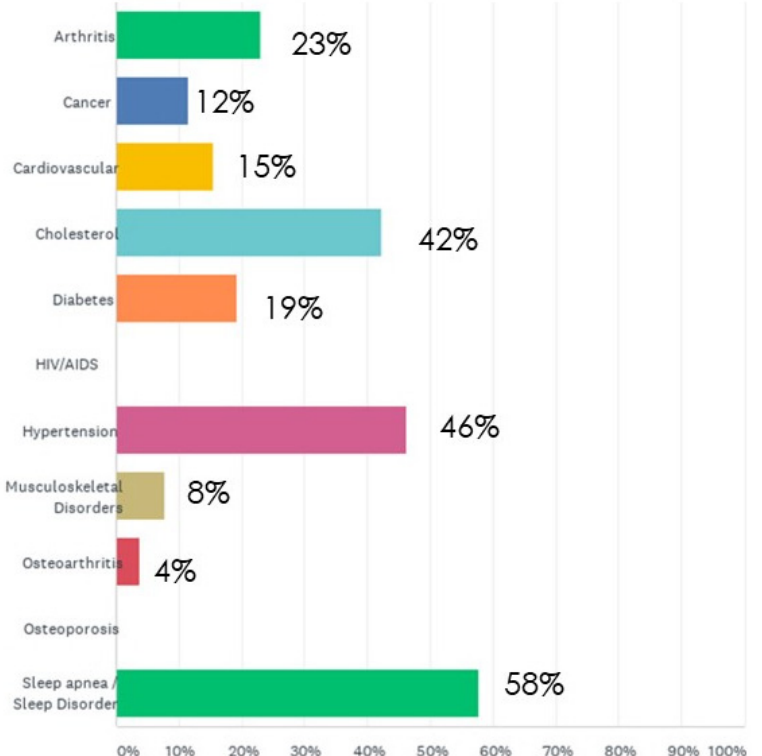
Figure 2. A graph reporting participant’s chronic disease from their survey. Participants fi lled out survey questionnaires providing information on their chronic diseases. Out of the 36 participants (n = 36), the majority of the participants reported having sleep apnea, hypertension, and cholesterol. had hypertension, and 42% had cholesterol.